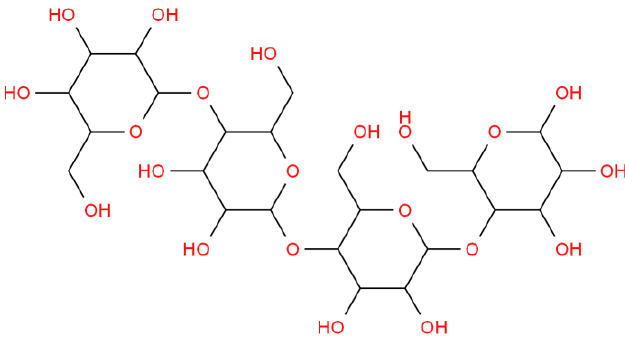
Figure 1. Chemical Structure of Glucomannan.